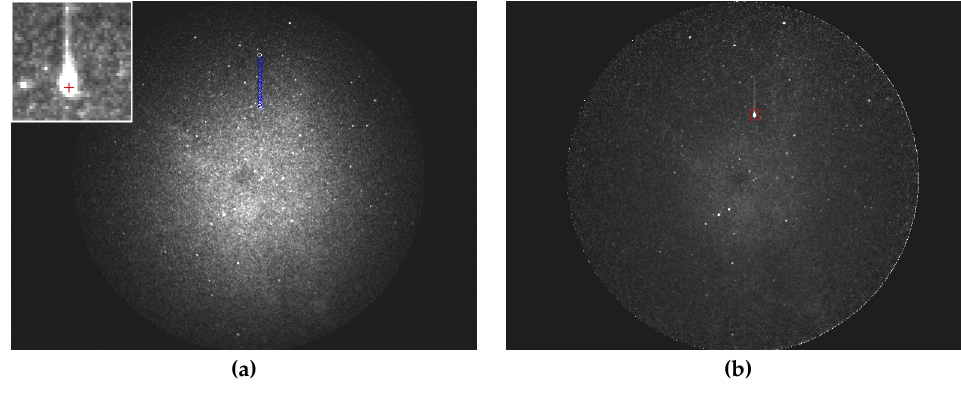
Figure 9. Measurement of meteor parameters. ( a ) Detected Meteor’s path and its magnified detail; ( b ) Meteor signal measured within the box for each